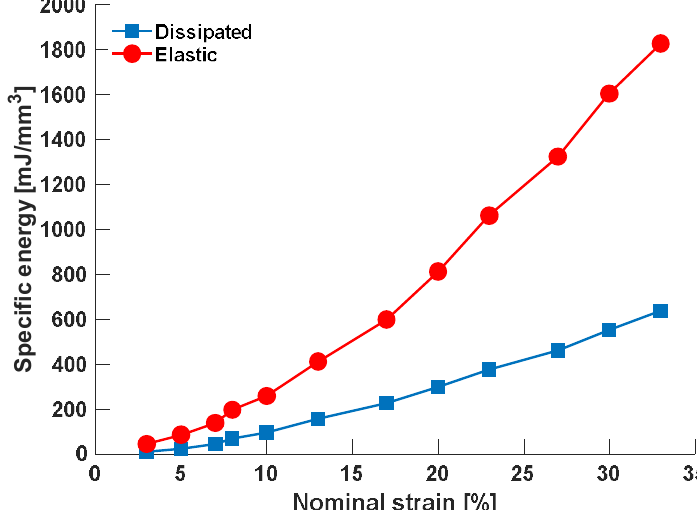
Figure 14. Dissipated and elastic parts of the specific deformation energy as function on the nominal strain.